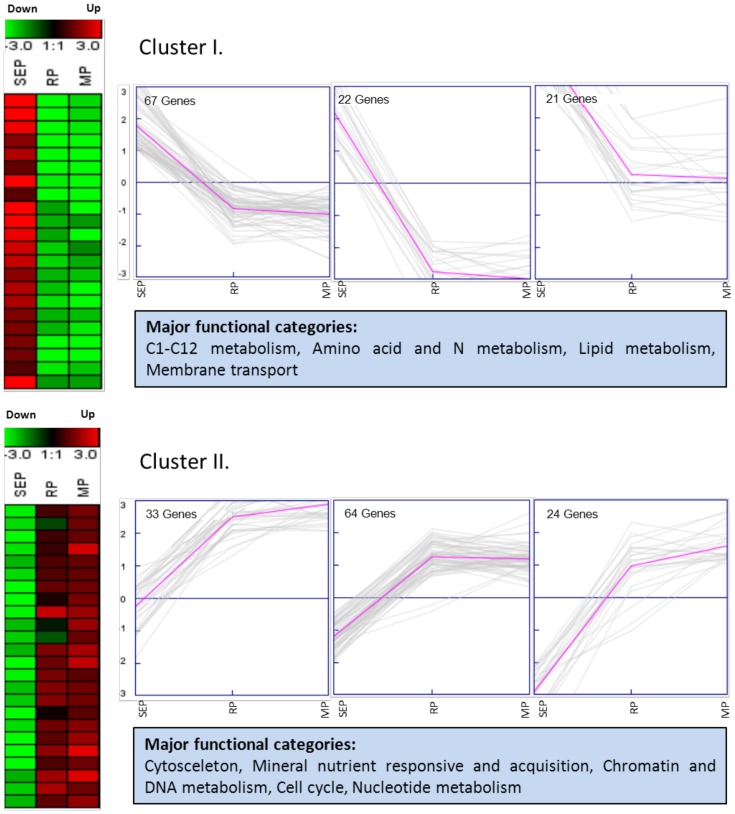
Cluster analysis.Two major clusters of genes specifically induced during different phases of AR formation created via K-means clustering method by Genesis software. Three types of associated expression graphs of each cluster are shown. SEP: Sink Establishment Phase; RP: Recovery Phase; MP: Maintenance Phase.